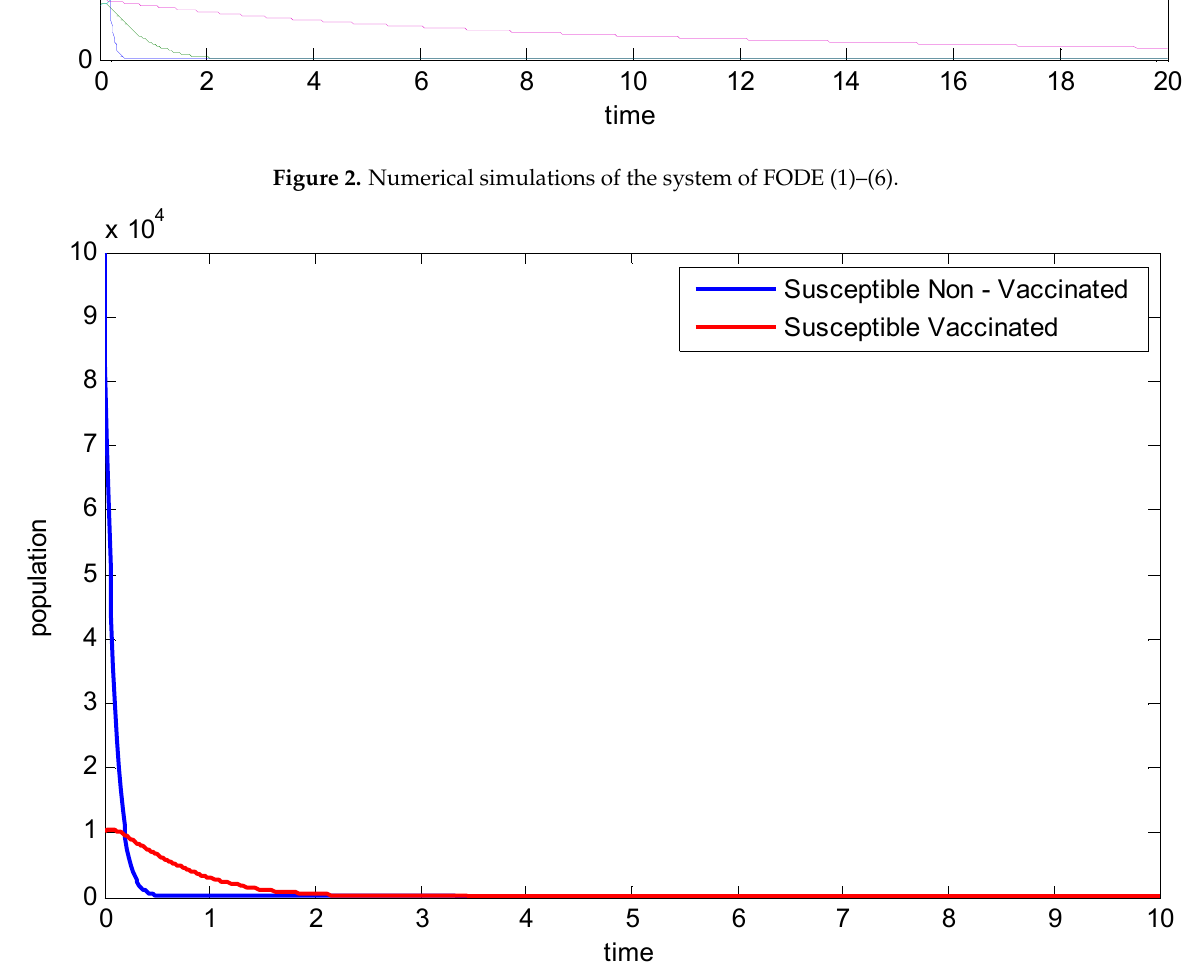
Figure 2. Numerical simulations of the system of FODE (1)–(6).